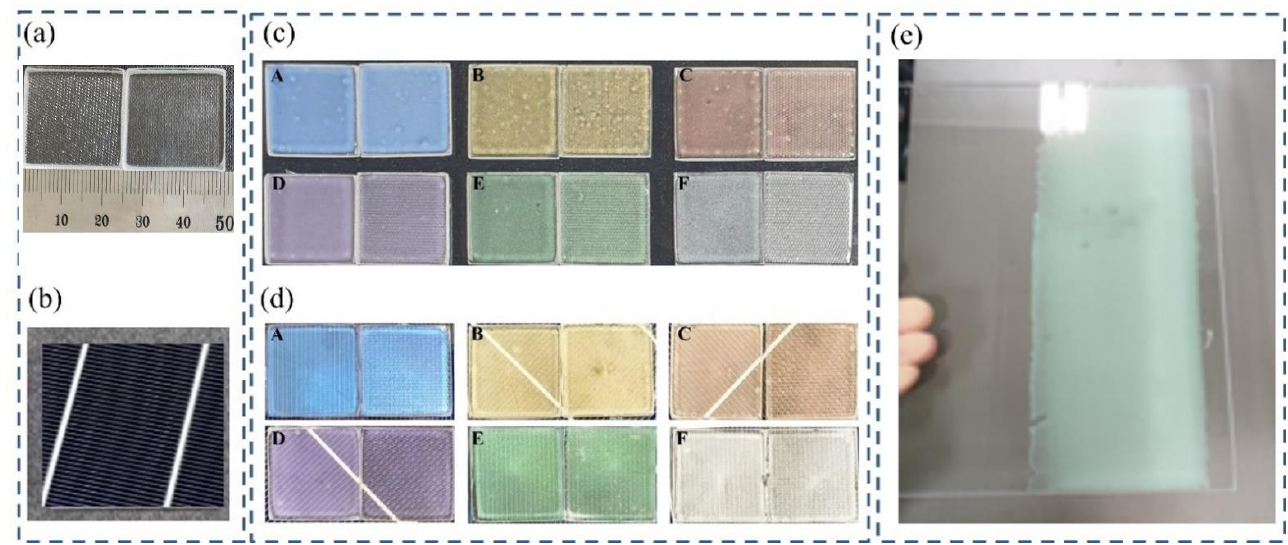
Figure 6. Actual photographs of ( a ) Normal and mist glass without a color layer, ( b ) PV cell, ( c ) samples A to F made at a spin coating speed of 1000 rpm, ( d ) laminated samples A to F (Left: Normal glass, right: mist glass), and ( e ) slot-die coated colored glass.